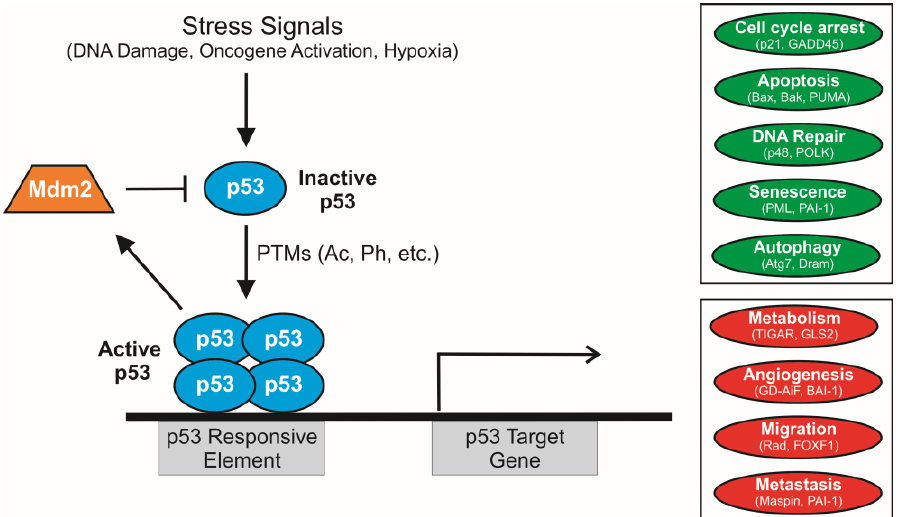
Figure 1. Cellular stress leads to p53 transcriptional activation of downstream